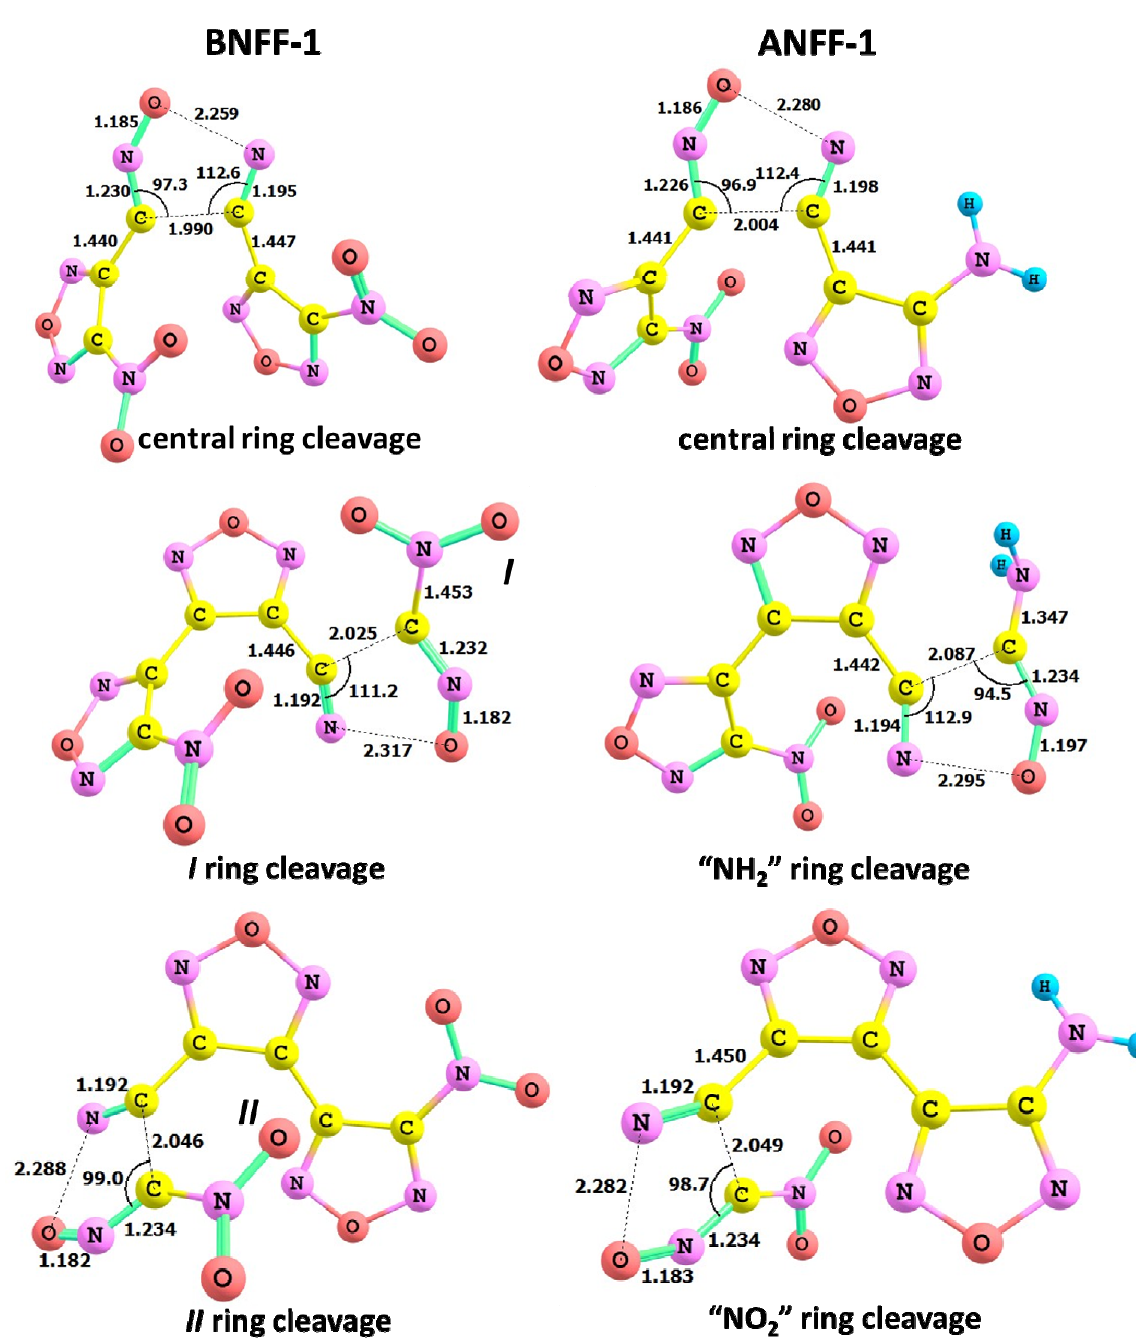
Figure 7. The structures of transition states for ring cleavage reactions in BNFF-1 and ANFF-1. The bond distances (Å) are obtained with M06